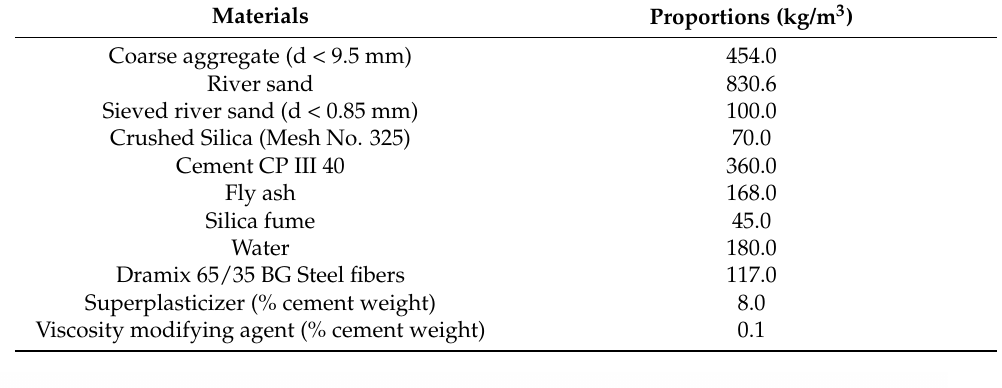
Table 1. Material proportions [44].